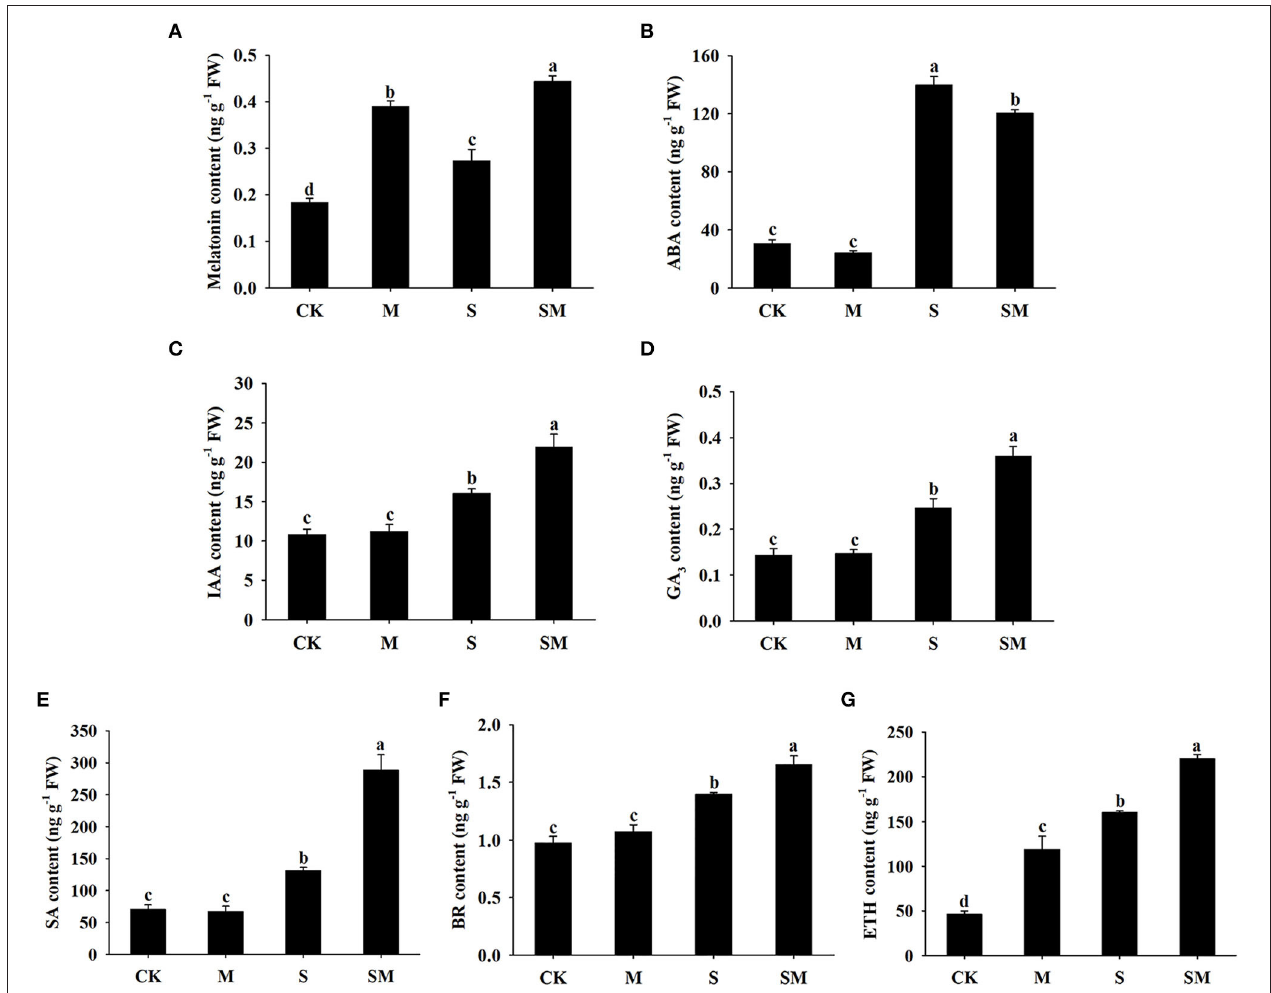
FIGURE 9 | Effect of exogenous melatonin on the endogenous hormone levels of alfalfa seedlings after 15 days of 150-mM NaCl treatment. (A) Melatonin content, (B) ABA content, (C) IAA content, (D) GA 3 content, (E) SA content, (F) BR content, and (G) ETH content. The data are means ± SE ( n = 3) and different letters are significantly different ( p <